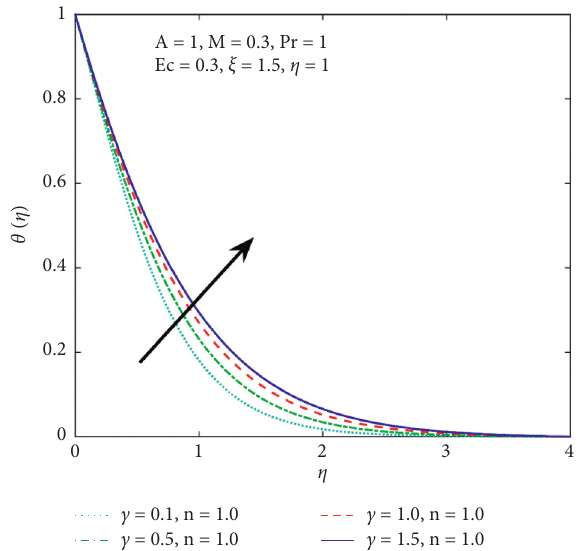
Figure 6: Thermal profile θ ( η ) for different values of curvature parameters ( c ) .